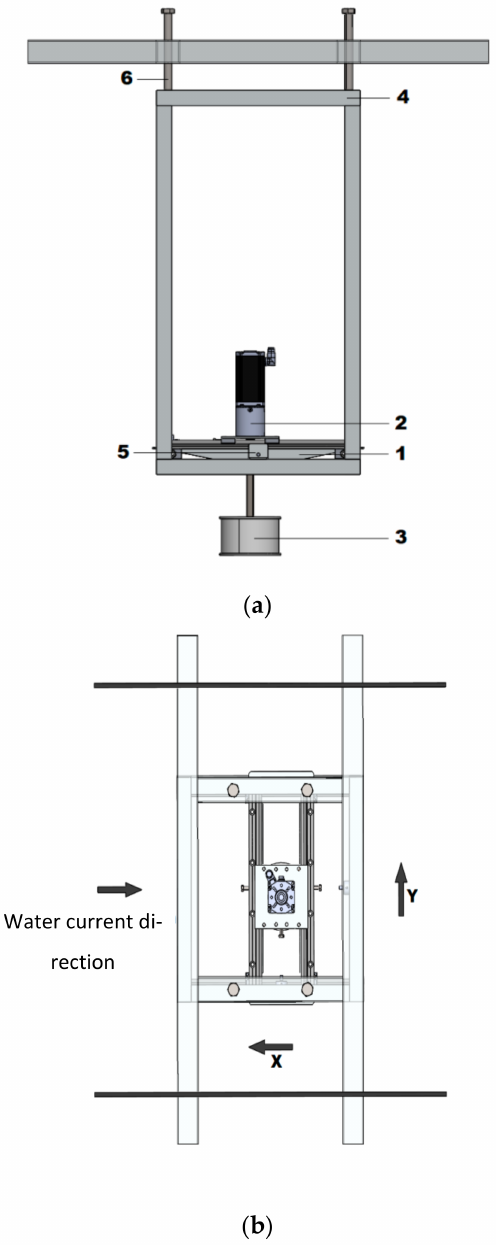
Figure 3. The force measuring part of the experimental test setup: ( a ) side view: 1—bearing-mounted platform, 2—drive system, 3—cylinder, 4—support frame, 5—force sensors, and 6—adjusting screw; ( b ) top